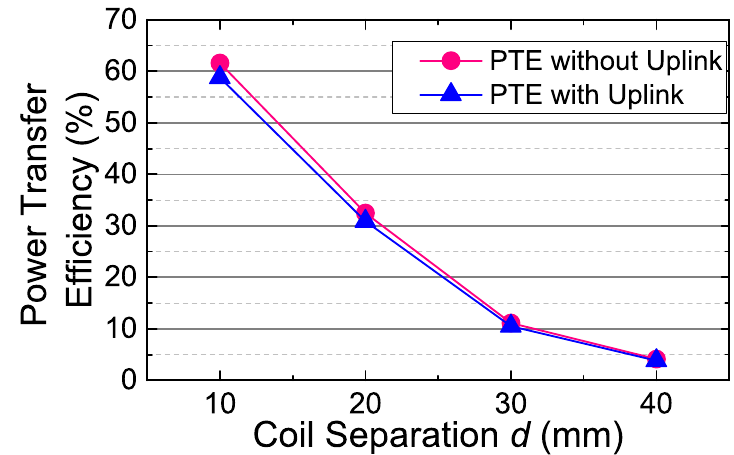
Figure 15. The power transfer efficiency versus coil separation d with or without connecting the uplink circuits, which includes the isolation resistors and the uplink transmitter. PTE, power transfer